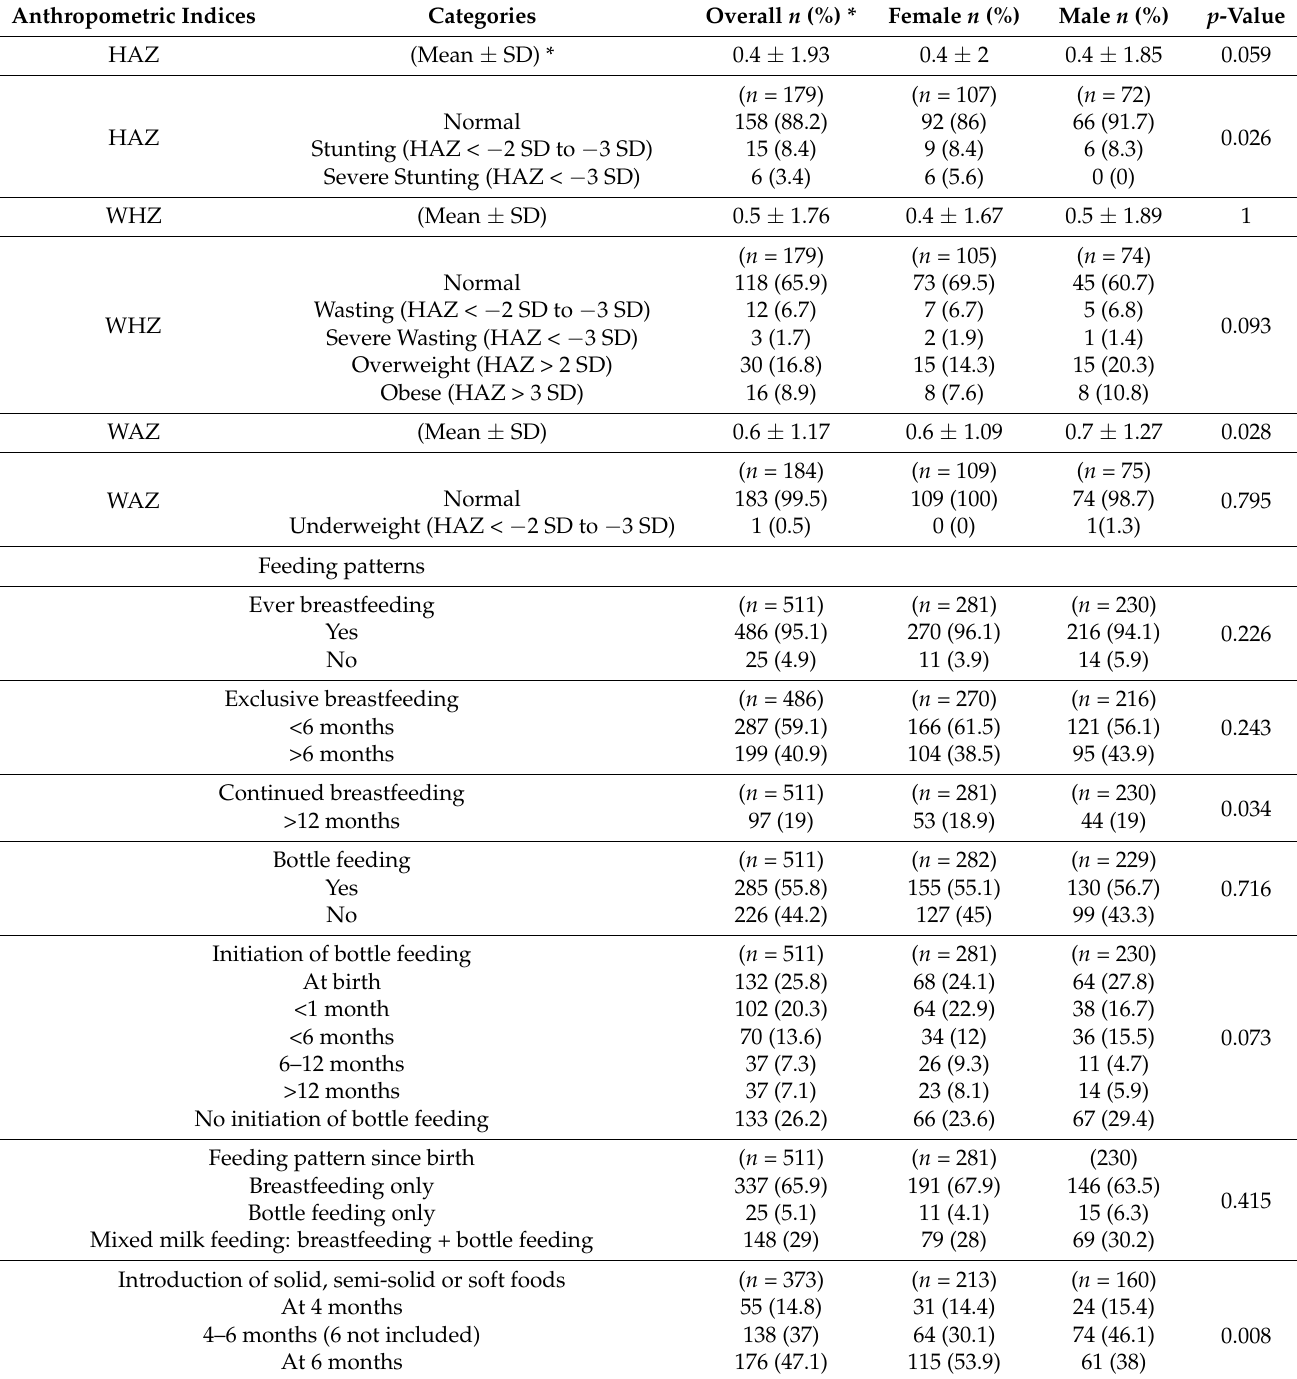
Table 3. Prevalence of malnutrition and feeding patterns among under-5 children in